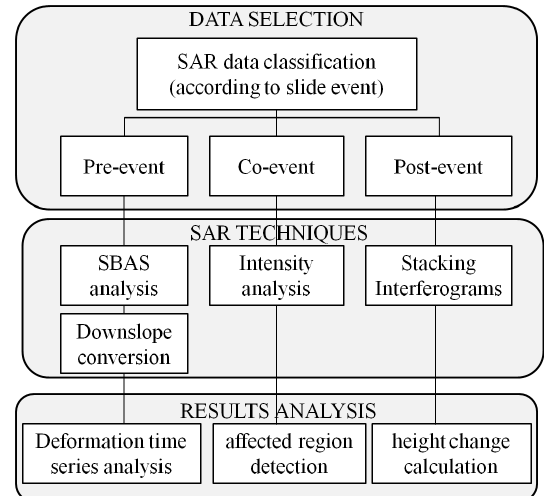
Fig. 3. The flow chart of SAR analysis for pre-, co-, and post-slide analysis 551